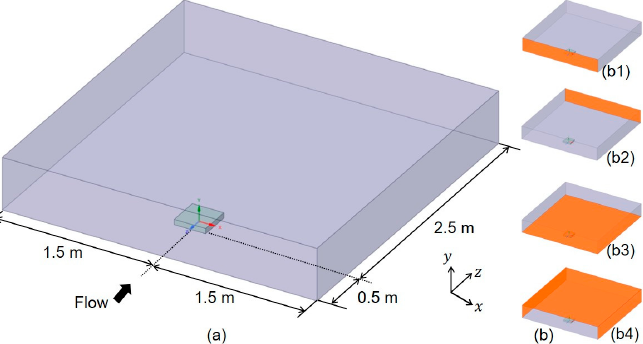
Figure 4. Flow domain ( a ) and boundary conditions ( b ) showing inlet ( b1 ), outlet ( b2 ), bottom ( b3 ), and symmetry ( b4 ).